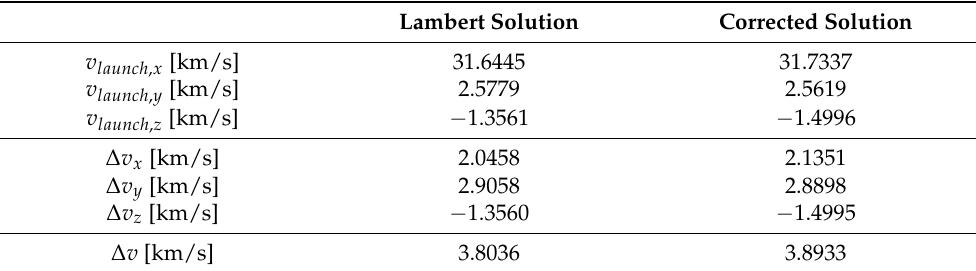
Table 5. Comparison of the velocities obtained by solving Lambert’s problem and their value after undergoing iterative correction for the interception to take place in a perturbed environment.